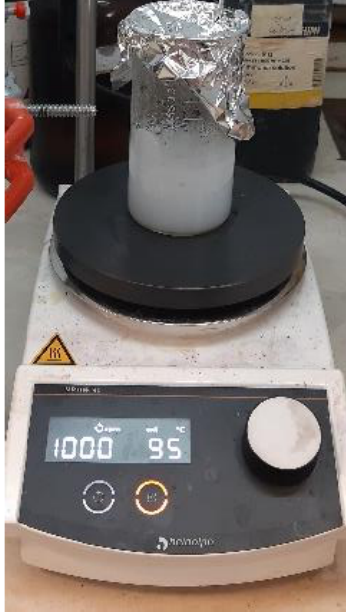
Figure1 : Nanoparticles precipitate was mixed with 100 ml of deionized water and placed at 100 ° C for 5 and a half hours